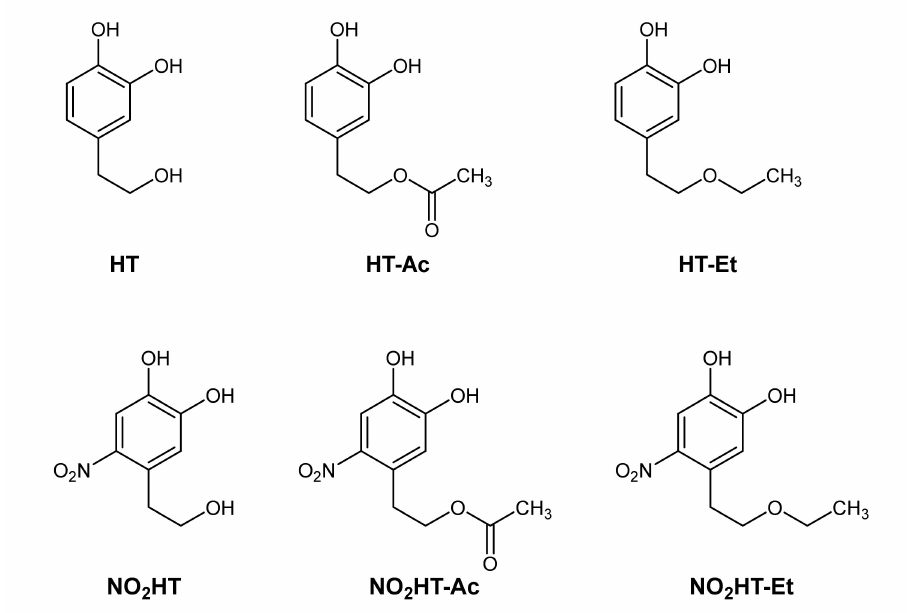
Figure 1. Chemical structures of the tested compounds. Hydroxytyrosol (HT) and derivatives: hydroxytyrosyl acetate (HT-Ac), ethyl hydroxytyrosyl ether (HT-Et), nitrohydroxytyrosol (NO 2 HT), nitrohydroxytyrosyl acetate (NO 2 HT-Ac), and ethyl nitrohydroxytyrosyl ether (NO 2